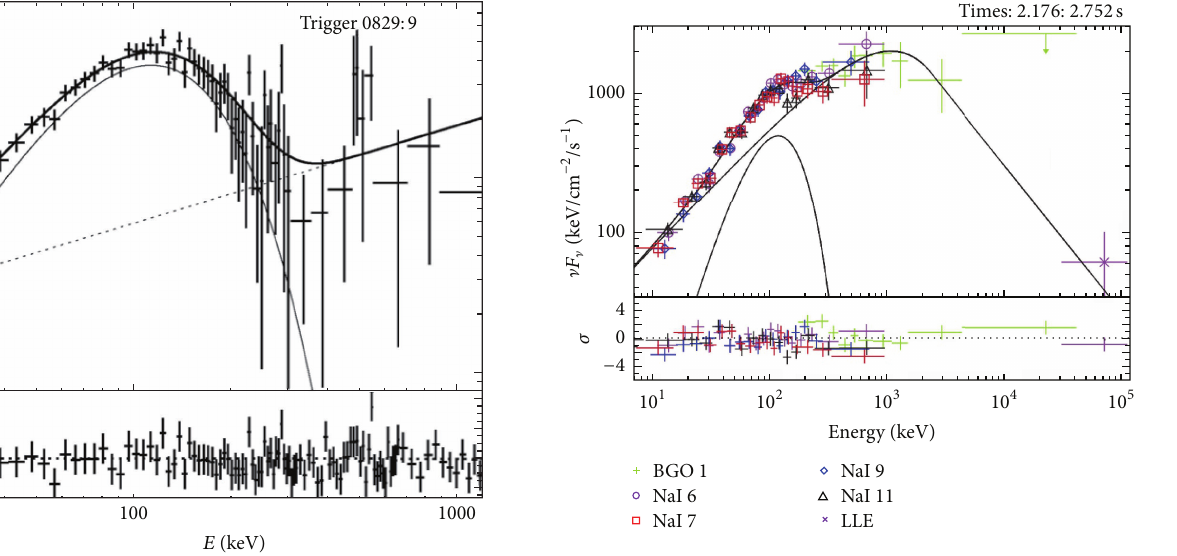
Figure 6: A “hybrid” model fit to the spectra of GRB 910927 detected by BATSE. Figure courtesy of Ryde.